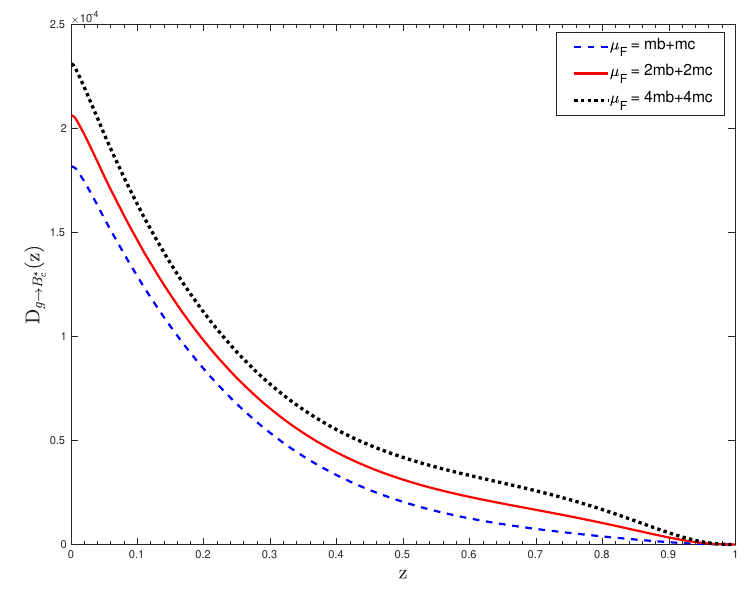
Figure 3 . The fragmentation function D g → B ∗ and µ F = 4 M , where the strong coupling constant is fixed as α s (2 m c ) = 0 . 259